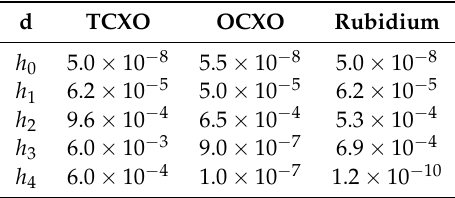
Table 1. Clock model power spectral density (PSD)